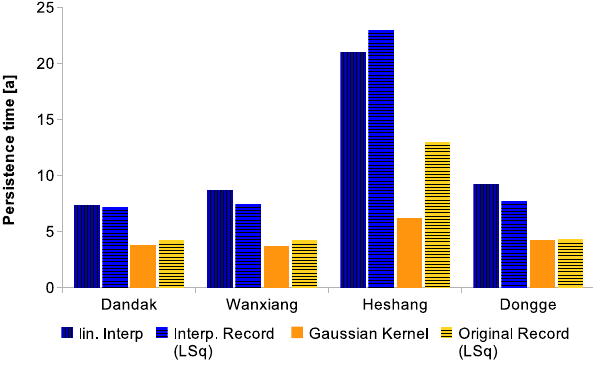
Fig. 13. Persistence times of the δ 18 O records estimated using lin- ear interpolation ACF estimate, Gaussian kernel ACF estimate and the least squares fitting of AR(1) processes (denoted by LSq) on interpolated and original